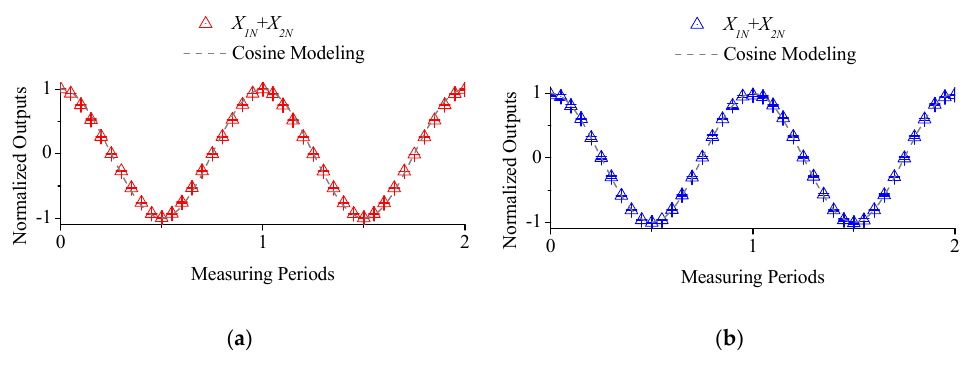
Figure 6. Demodulated sensor signal in X direction: ( a ) normalized outputs; ( b ) fundamental wave component of an EMD-based extraction approach.